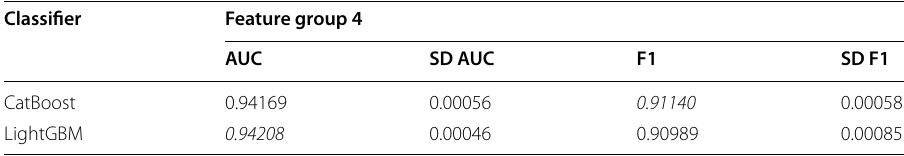
Best metrics are highlighted in italics; SD AUC is the standard deviation of AUC and SD F1 is the standard deviation of the F1-score